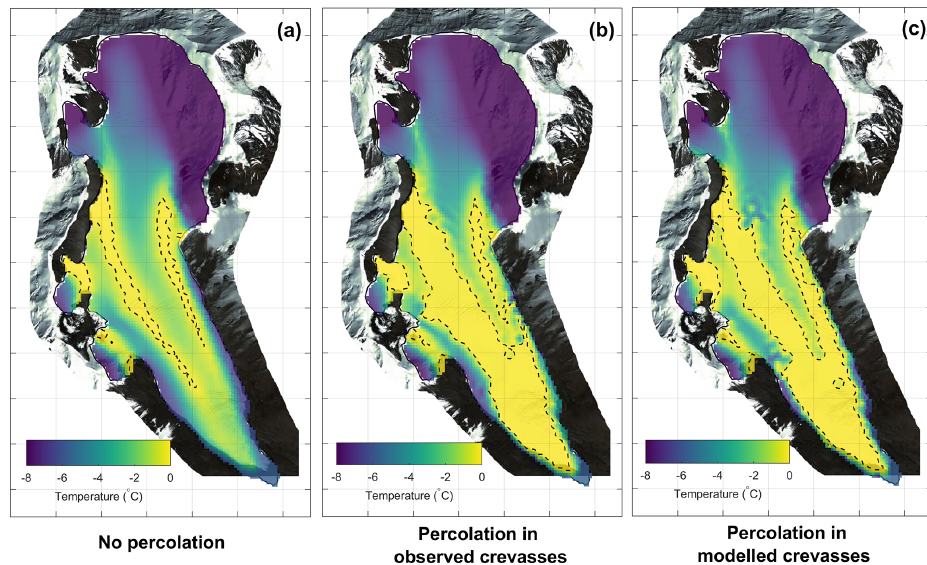
Figure 9. Modelled steady-state basal temperature. (a) Without crevasse influence. (b) With water percolation in observed crevassed areas. (c) With water percolation in modelled crevassed areas. Dashed lines delimit the temperate